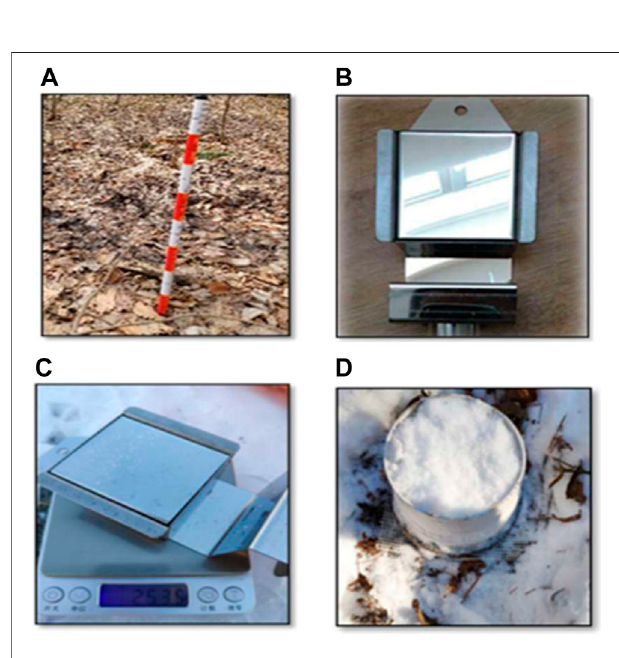
FIGURE 3 | Investigation methods to determine snow cover characteristics: (A) snow depth ruler, (B) rectangular snow box cutter, (C) weight to determine the snow mass, and (D) snow sublimation rate measurement